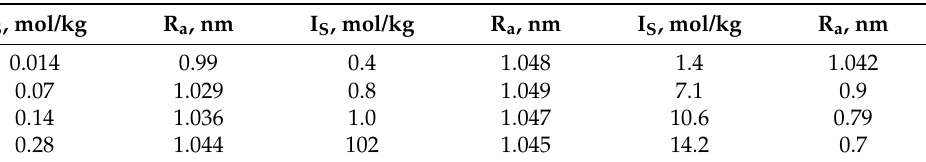
Table 8. The final average size of silica particles in solutions with different ionic strength values. t = 20 °C, pH = 8.0, and Cs = 700 mg/kg.